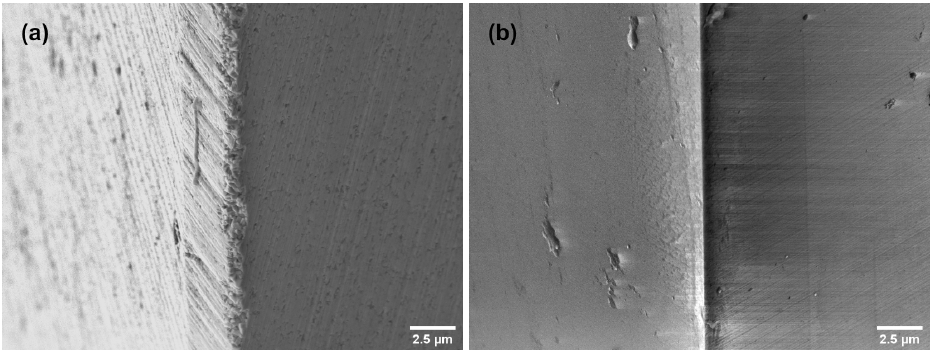
Figure 4. SEM-image on the flank ( left ) and rake ( right ) face of ( a ) SC-tool. ( b ) MD-tool.